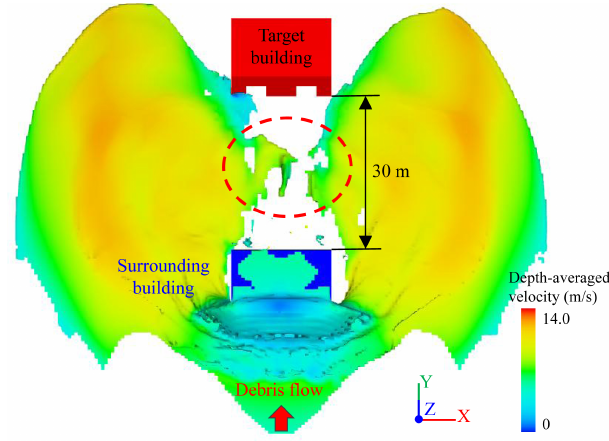
Figure 11. There is the lower debris flow intensities further away surrounding building within a shielding area, in the scenario of Or90-Op0.4- A 0- D 30 at a simulation time of 8.0s. The local de- bris flow conflux is delineated with the dotted red line (the snapshot has been rotated 30 ◦ counterclockwise along the x axis, similarly